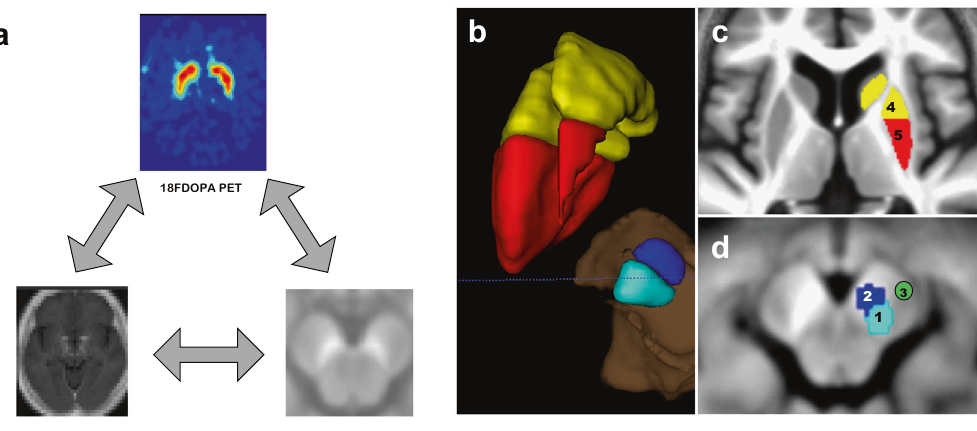
Fig. 1 Analyses design and de fi nition of substantia nigra and striatum masks. a Diagram showing the three types of relationship explored in this study, between NM-MRI, R2* maps, and F-DOPA PET scan. This diagram will be recalled beside every correlation studied. b Tridimensional view of left SN and striatum with their divisions. c Axial slice at the level of basal ganglia on the mean structural image of the whole population sample (PD + HC), showing striatum delineation. Precommissural striatum is depicted in yellow (4) and postcommissural striatum in red (5). This division is supported by anatomical and functional data 20,87 . d Axial slices at the level of midbrain on a NM-MRI, showing substantia nigra delineation, with division in lateral tiers (1, light blue) and medial tiers (2, dark blue), according to neuropathological data 79 . Cerebral peduncle is also delineated (3, green).